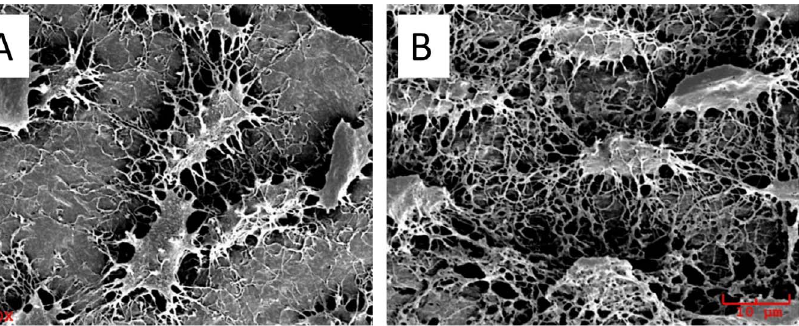
Figure 7. Representative/MMA-casted SEM images of the subchondral bone. A: in normal control, osteocytes are found on the solid bone matrix without obvious removal after acid processing; B: in the collapsed femur head region, osteocytes are presented without bone matrix surrounding, i.e. bone matrix removed after acid processing. (1500 6 ).